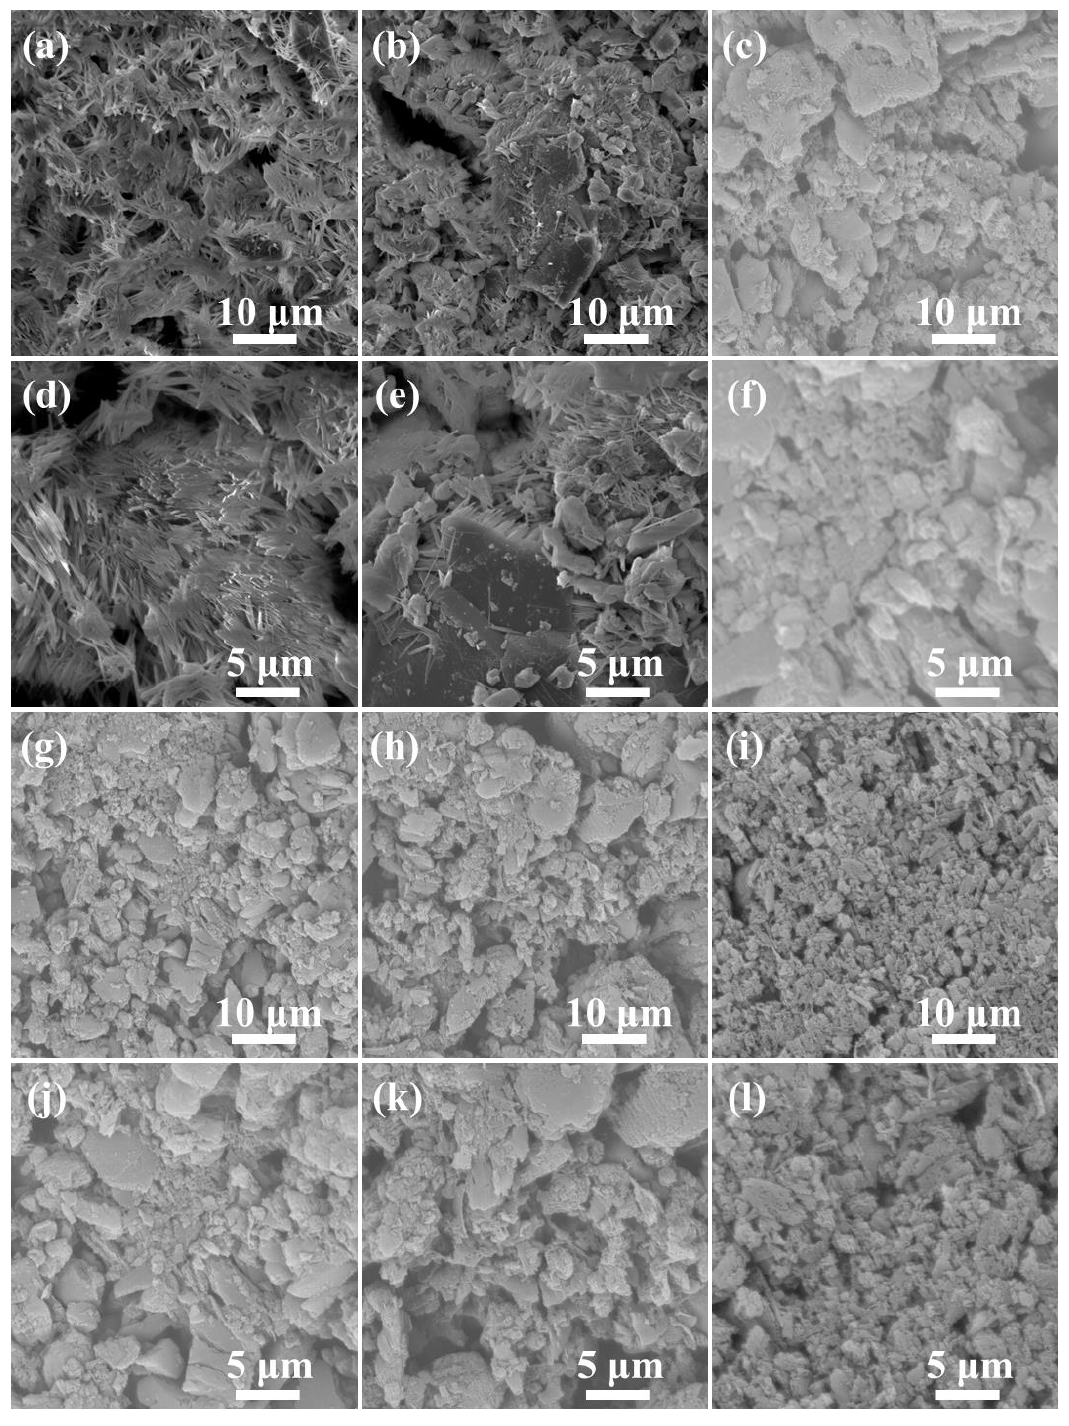
Figure 5. SEM images of CN-450 ( a , d ), CN-500 ( b , e ), CN-550 ( c , f ), CN-600 ( g , j ), CN-650 ( h , k ) and CN-700 ( i , l ).